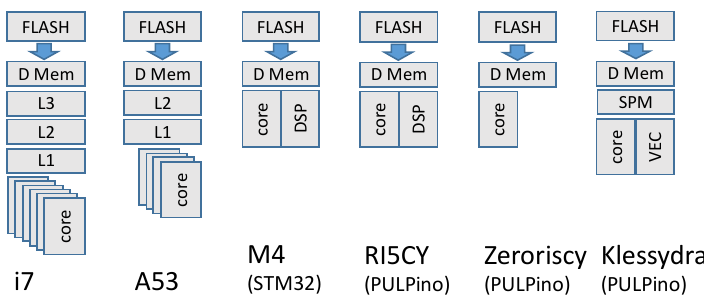
Figure 14. System architecture organization of the compared boards.